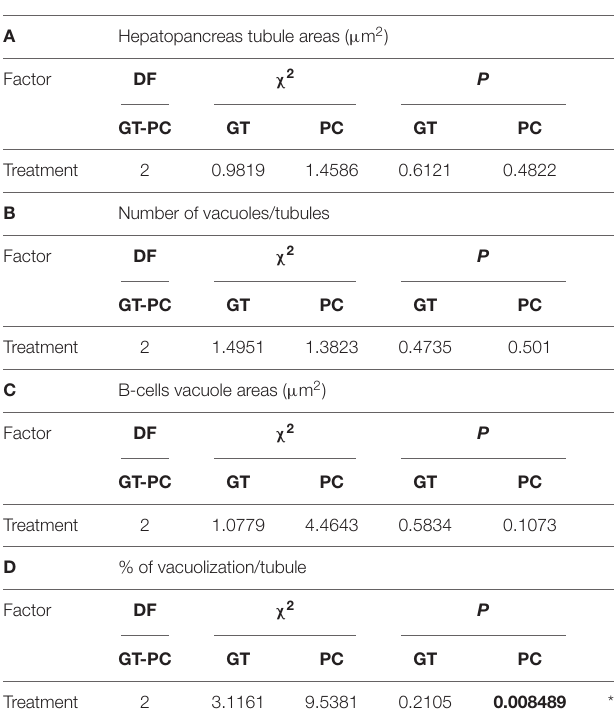
TABLE 1 | Results of analysis of deviance for histological measurements from transverse sections of different hepatopancreas tubules of G. tetragonon and P. chlorophthalmus as a function of treatment.